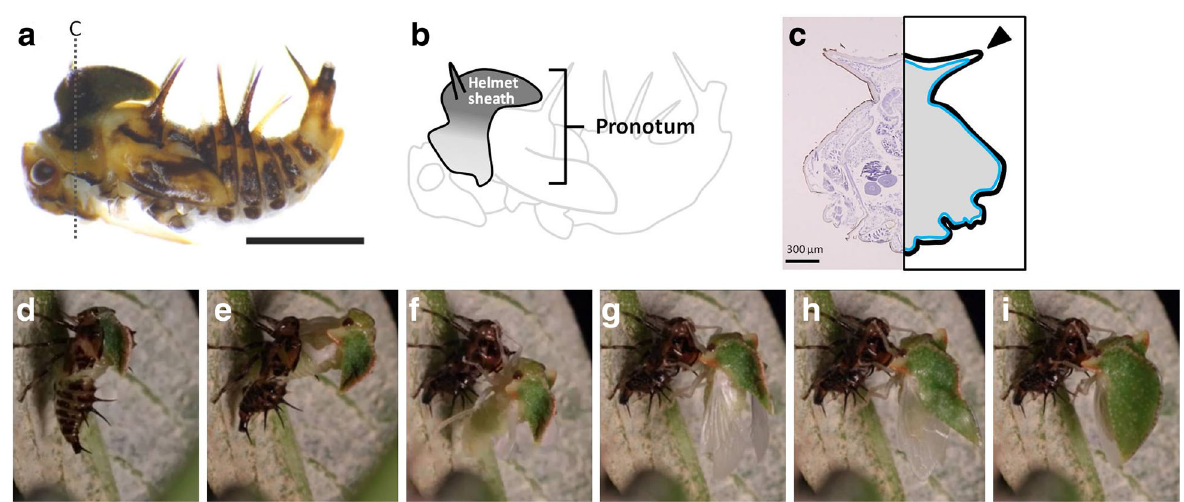
Fig. 4 Structure of nymphal pronotum of Antianthe expansa . a Side view of last instar nymph of Antianthe expansa (legs were removed). Scale bar indicates 2 mm. Sectioned region in C is indicated as a dashed line. b Schematic summary of pronotum and helmet sheath of final instar nymph. We call the dorsal projected region of the nymphal pronotum a “ helmet sheath ” indicated in dark gray. There is no clear border between the helmet sheath and other parts of the pronotum. b Frontal section of nymph. Note that the helmet sheath is monolayer (the epithelium is indicated by a blue line) and the inside of the helmet sheath is filled with tissue. c - h Time-lapse images of eclosion of an adult Antianthe expansa . Extremely folded structures (dense furrows) were extended to form the final 3D helmet structure. This transformation occurs in approximately 35 min, which indicates that cytological activities (e.g. cell division and migration, etc.) cannot play important roles in this